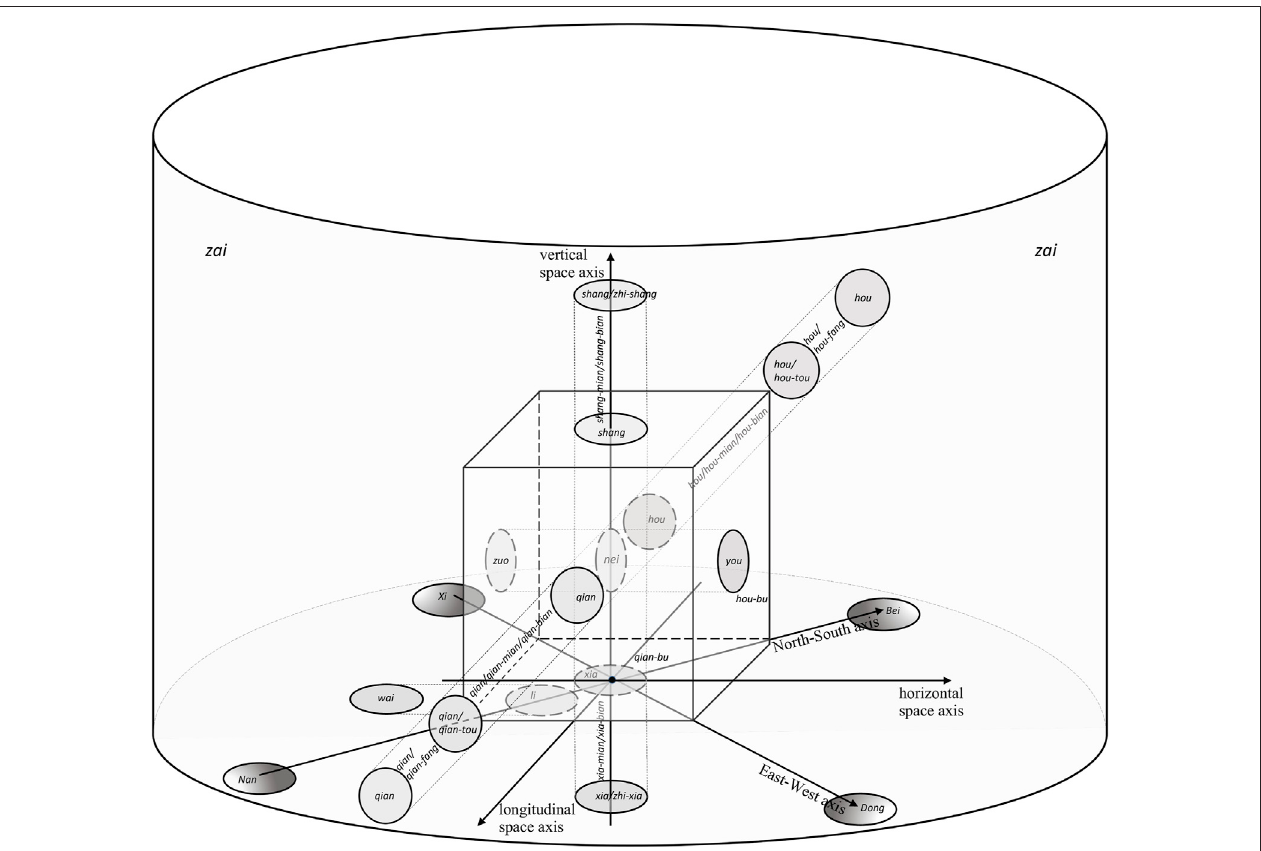
FIGURE 1 | The semantic map for zai and its range of possible locations. The map represents a ground as an idealised cube, abstracting away from the role of shape in determining the nature of the locations to which prepositions and localisers refer. Zai ’ s potential polysemy domain is represented as a cylinder-shaped ( “ halo ” ) region encompassing all the regions/locations that localisers refer to. For instance, the “ front ” location to which qian-mian refers is part of zai ’ s halo. Locations also carry different shades to represent the “ strength ” of hyponym relations. This fi gure represents this fact by having the four cardinal locations be in dark grey and other locations in light grey. A consequence of building semantic maps in this manner is that distinct categories may stand in hyponym-like relations. As our map shows, prepositions may refer to “ general ” regions, for speakers that accept their polysemy: localisers thus refer to more “ speci fi c ” regions within these general regions. Categorial distinctions play a role at a grammatical level of organisation, but not at a conceptual level.